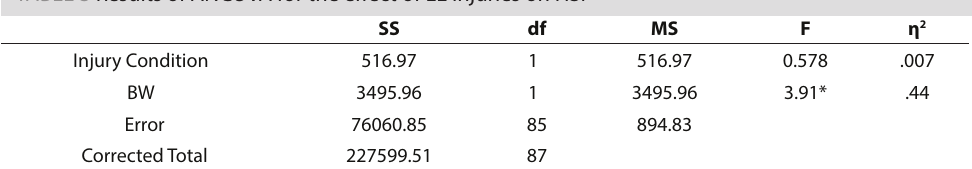
TABLE 3 Results of ANCOVA for the eff ect of LE injuries on